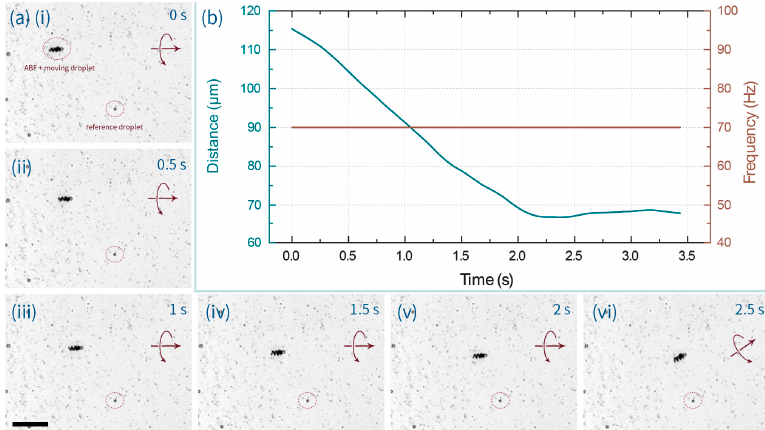
Figure 3. ( a ) Time lapse images of an ABF transporting a microdroplet within a 25 µm deep PDMS chamber, under the application of a 70 Hz, 7 mT magnetic field. The scale bar corresponds to 50 µm. ( i – vi ) Time lapse images at 0.5 s intervals. ( b ) Assessment of the relative distance between the transported droplet and a reference droplet as a function of time.